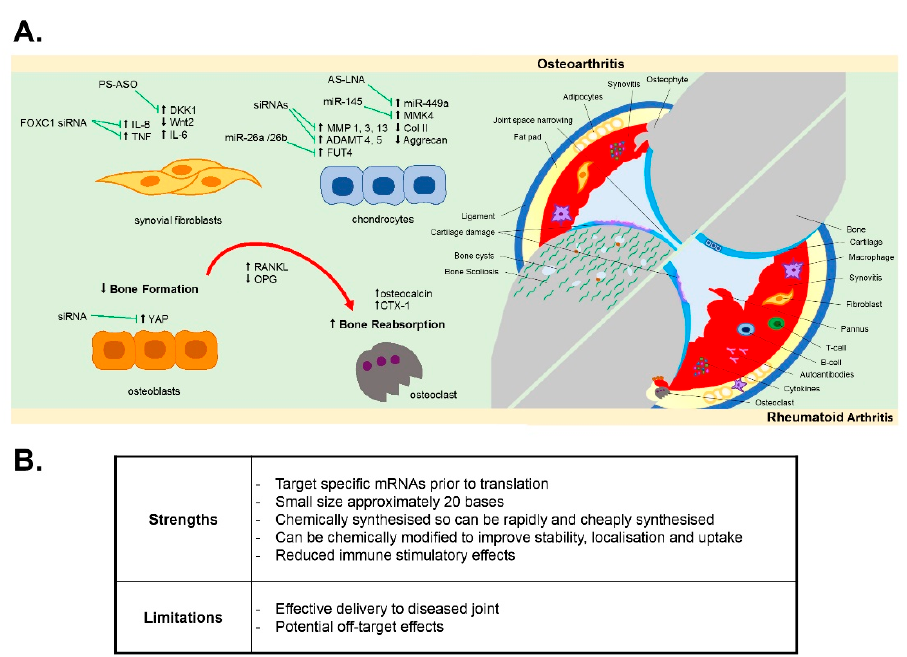
Figure 1. Features of OA and RA pathology and in vivo oligonucleotide targets. ( A ) RA is an autoimmune condition driven by inflammation of the synovial lining which degrades cartilage and activates osteoclast bone reabsorption, whilst OA is a degenerative joint disorder involving the loss of articular cartilage mass, ligament damage, subchondral bone sclerosis and fat pad and synovial inflammation. Inflammatory synovial fibroblasts, along with other joint cells, produce pro-inflammatory cytokines which stimulate RANKL production in osteoblasts, thus promoting osteoclastogenesis and bone resorption. Damaged cartilage exacerbates synovial inflammation, driving further cartilage loss. ( B ) Summary of the strengths and limitations of using oligonucleotides as therapeutics. ADAMTS 4, 5: a disintegrin and metalloproteinase with thrombospondin motifs 4, 5, AS-LNA: antisense locked nucleic acid, BMP: bone morphogenic proteins, Col II: collagen type 2, CTX-1: cytotoxin-1, DKK1: Dickkopf-elated protein 1, FOXC1: forkhead box C1, FUT4: fucosyltransferase 4, IL-6, 8: interleukin-6, 8, miR-26a, 26b, 145, 449a: microRNA-26a, 26b, 145, 449a, MMK4: mitogen activated protein kinase, MMP-1, 3, 13: matrix metalloproteinase-1, 3, 13, OA: osteoarthritis, OPG: osteoprotegerin, PS-ASO: phosphorothioate antisense oligonucleotide, RA: rheumatoid arthritis, RANKL: receptor activator of nuclear factor kappa- Β ligand, siRNA: small interfering RNA, TNF: tumor necrosis factor, Wnt2: Wnt family member 2, YAP: yes-associated protein.